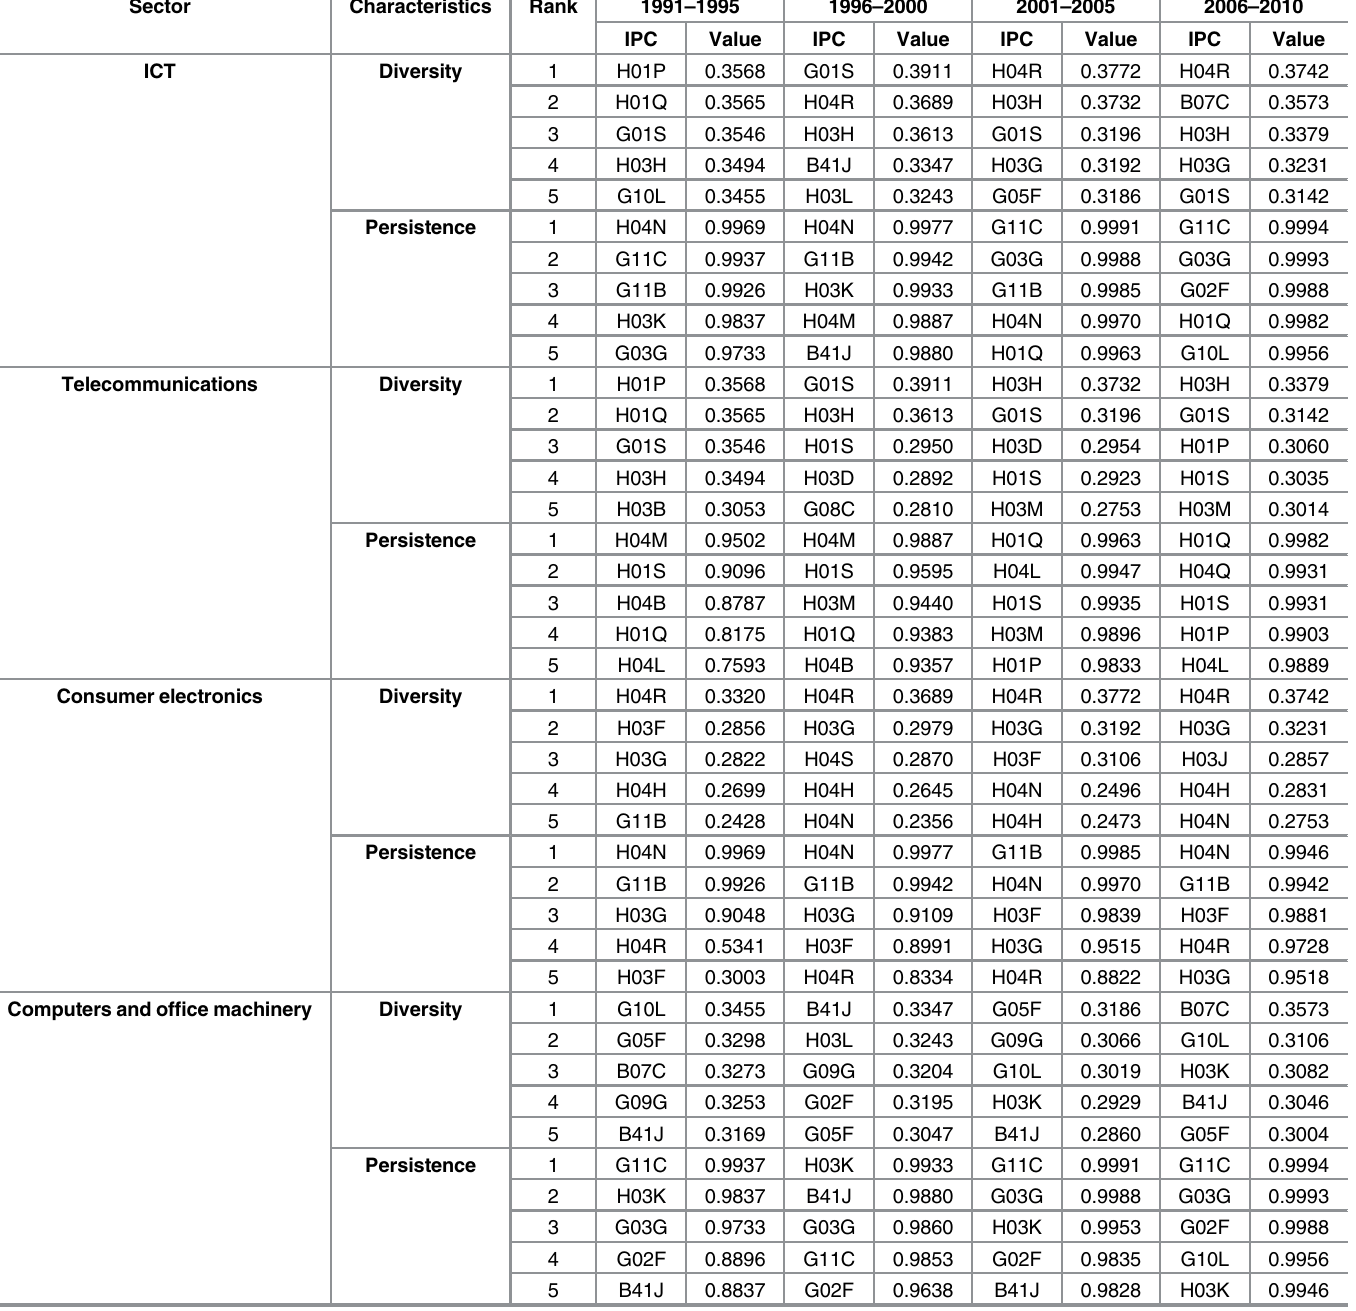
Table 11. Diversity and Persistence Values of IPCs in ICT, BT, and NT Sectors in Korea.